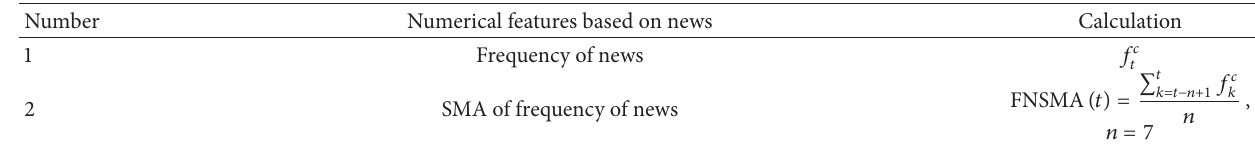
Table 3: List of numerical features of news items.